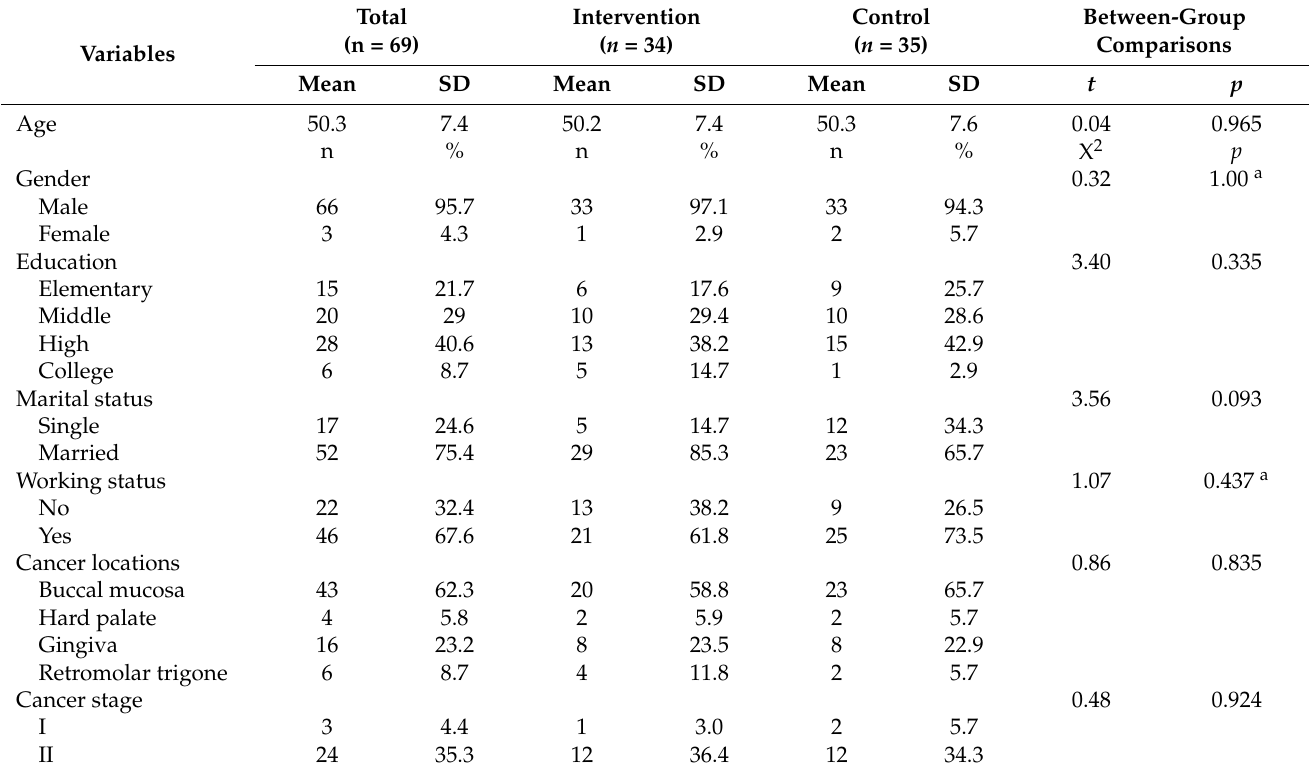
Table 1. Demographics and baseline